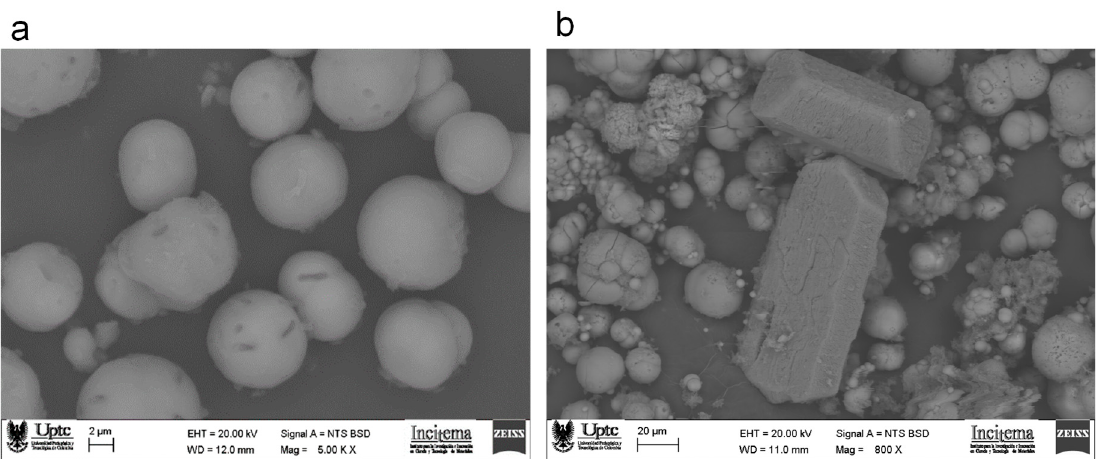
Figure 5. SEM micrographs of biogenic CaCO 3 obtained with ( a ) nutrient broth (100 NB) shows vaterite crystals, and ( b ) whey (100 W) with calcite crystals.